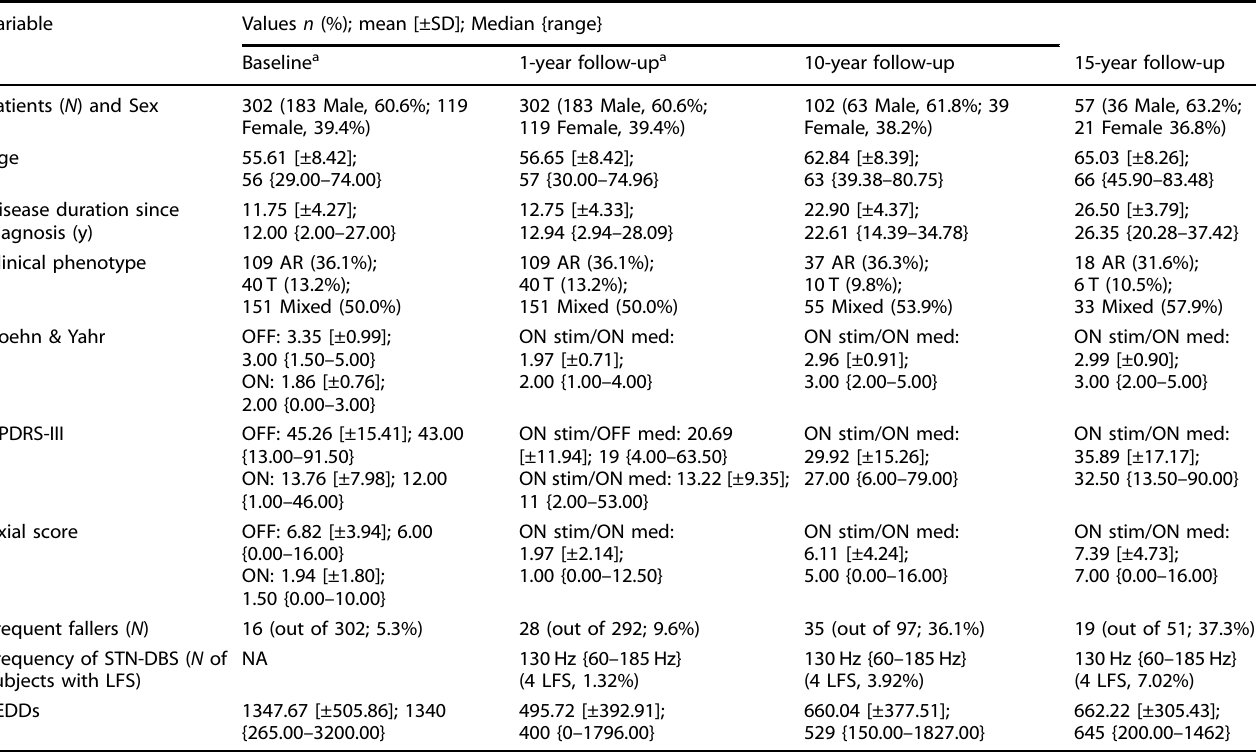
Table 1. Demographic and clinical features of people with Parkinson ’ s disease and subthalamic deep brain stimulation at baseline and follow-ups.